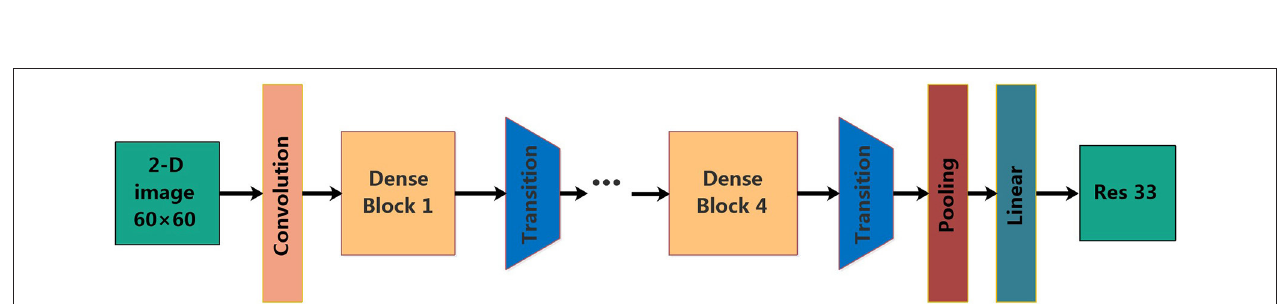
FIGURE 2 | The structure of the